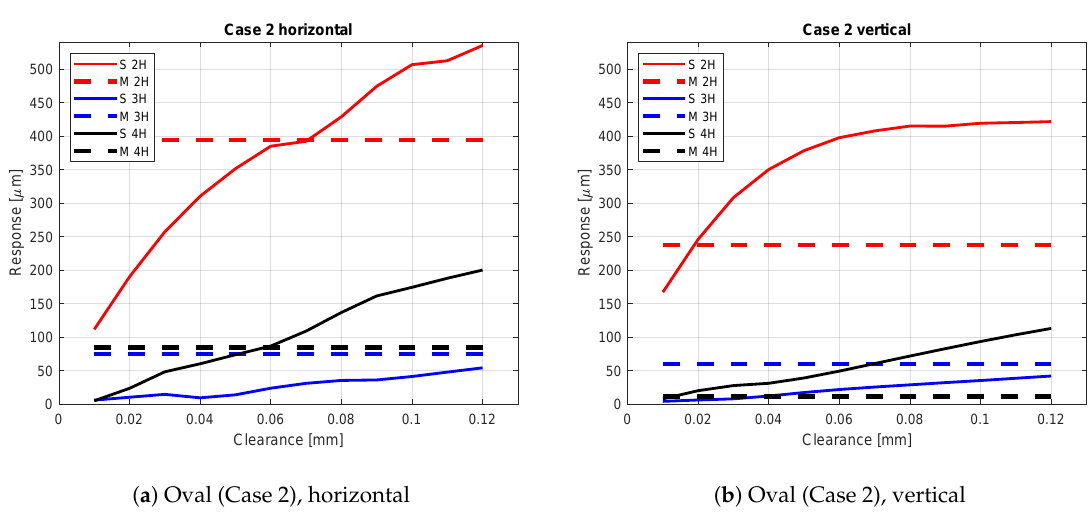
Figure 12. Case 2—oval bearing inner ring roundness profile in the service